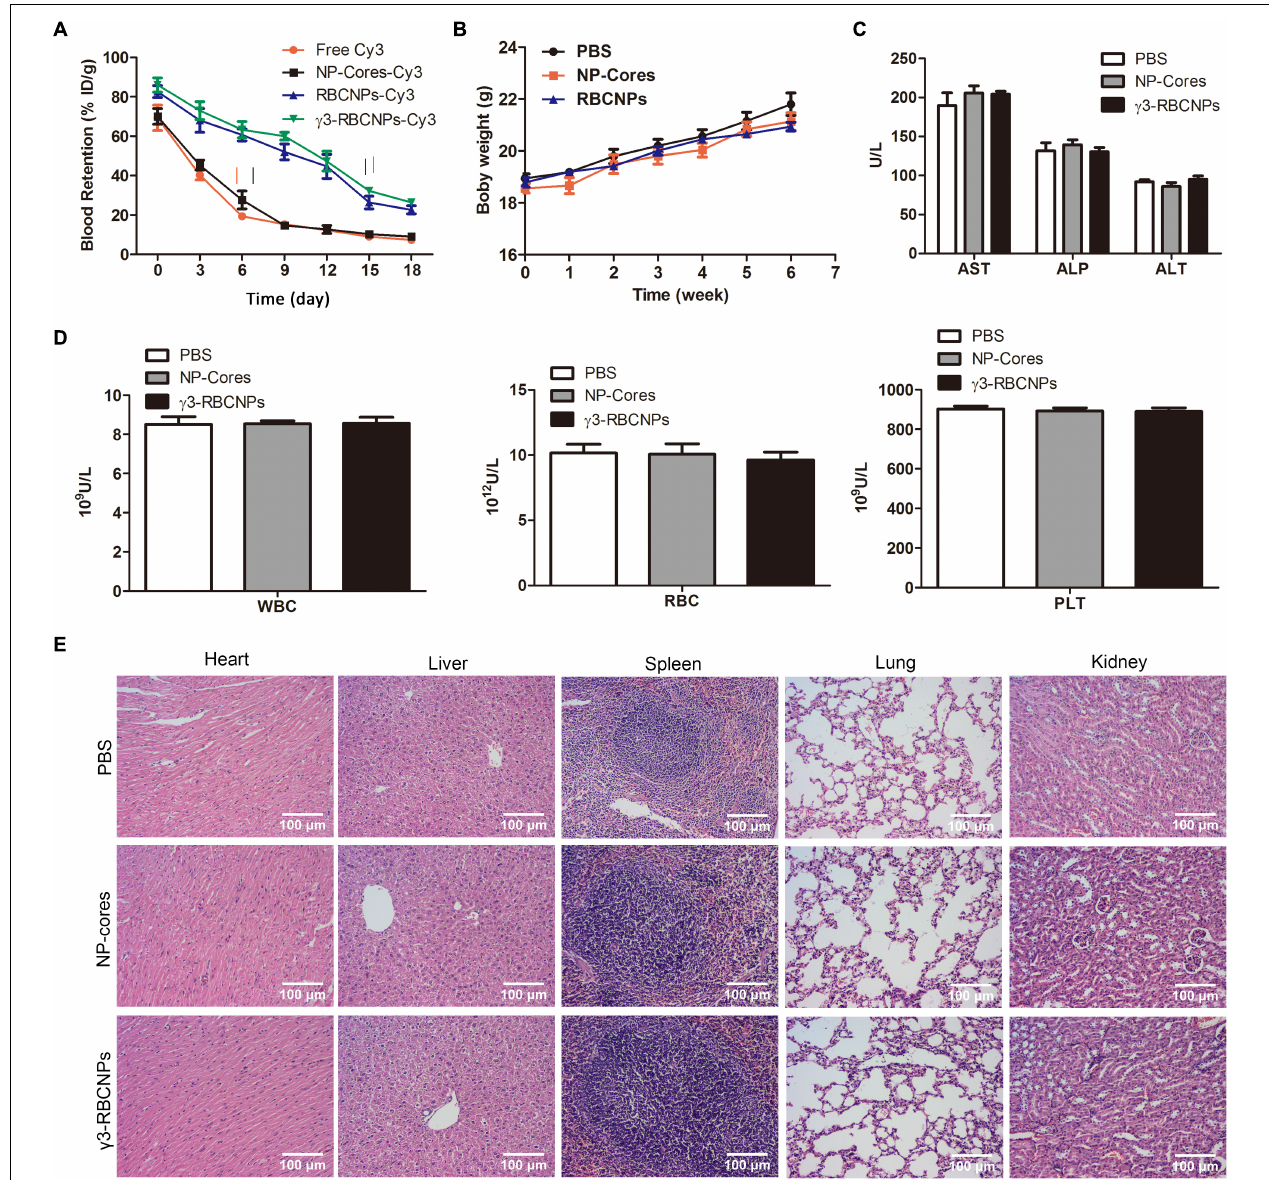
FIGURE 6 | Assessment of the bio-safety of γ 3-RBCNPs in vivo . (A) Evaluation of half-life of the drug in NP-cores, RBCNPs, and γ 3-RBCNPs in vivo . The changes of body weight (B) , liver function (C) and blood routine (D) indexes of mice with acute pulmonary infection treated with NP-cores, RBCNPs, and γ 3-RBCNPs. (E) H&E staining of the main tissues in mice. Scale bar = 100 µ